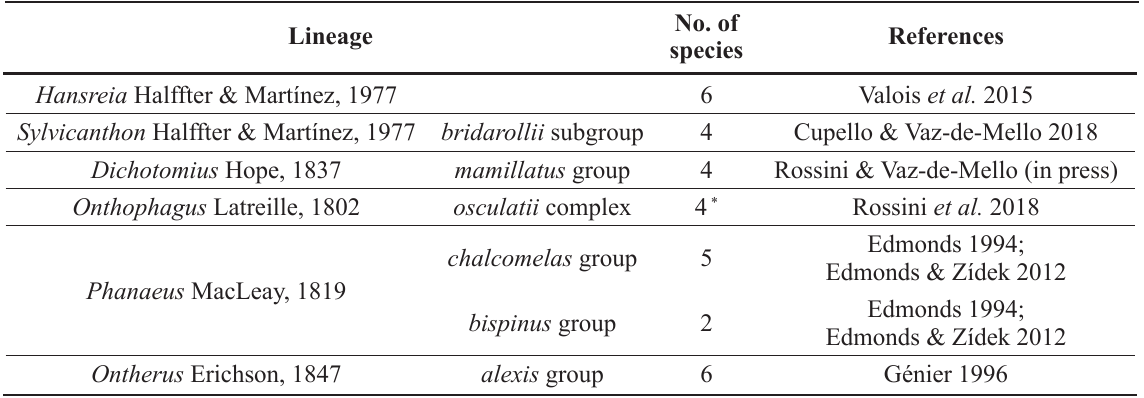
Table 2. Dung beetle lineages endemic in South America east of the Andes to the Amazonia. No. Lineage